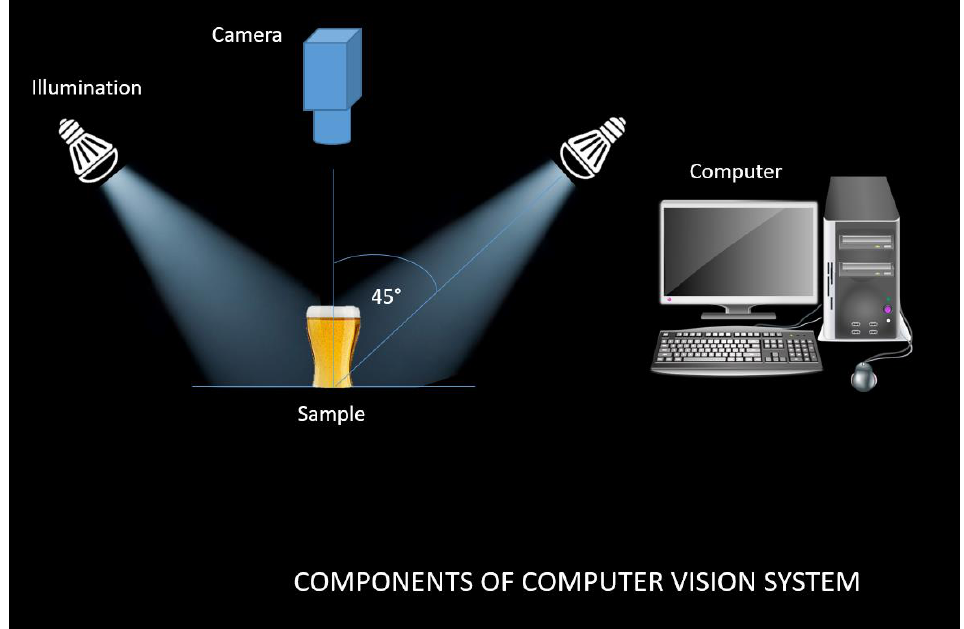
Figure 1. Components of a computer vision system.